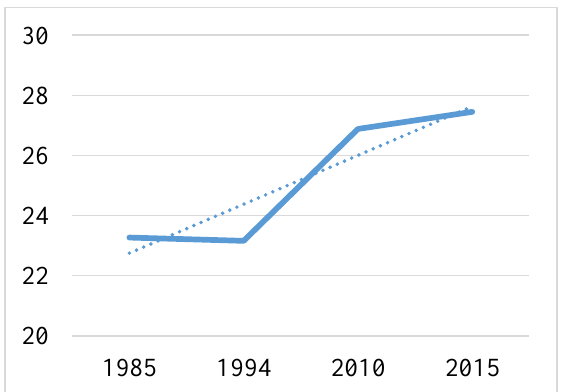
Figure 7. LST (°C) in 1985, 1994, 2010, and 2015